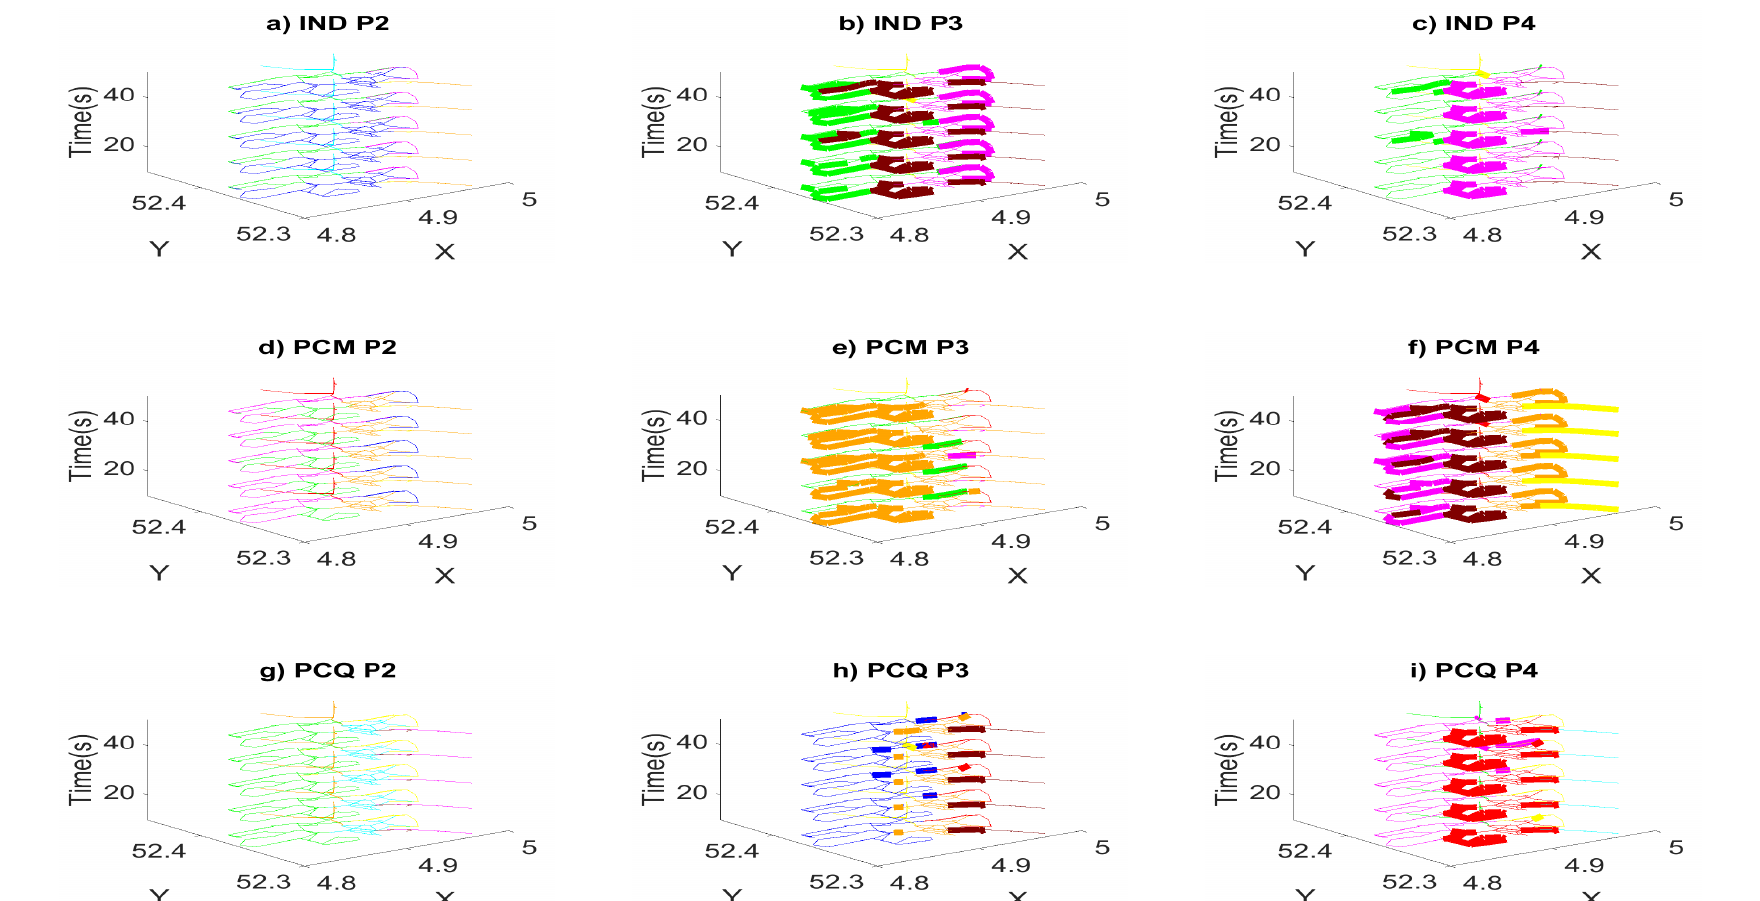
Figure 24. Clustering results for time periods from t = 2 to t = 4 for the IND, PCM and PCQ methods in the case of a time period equal to one